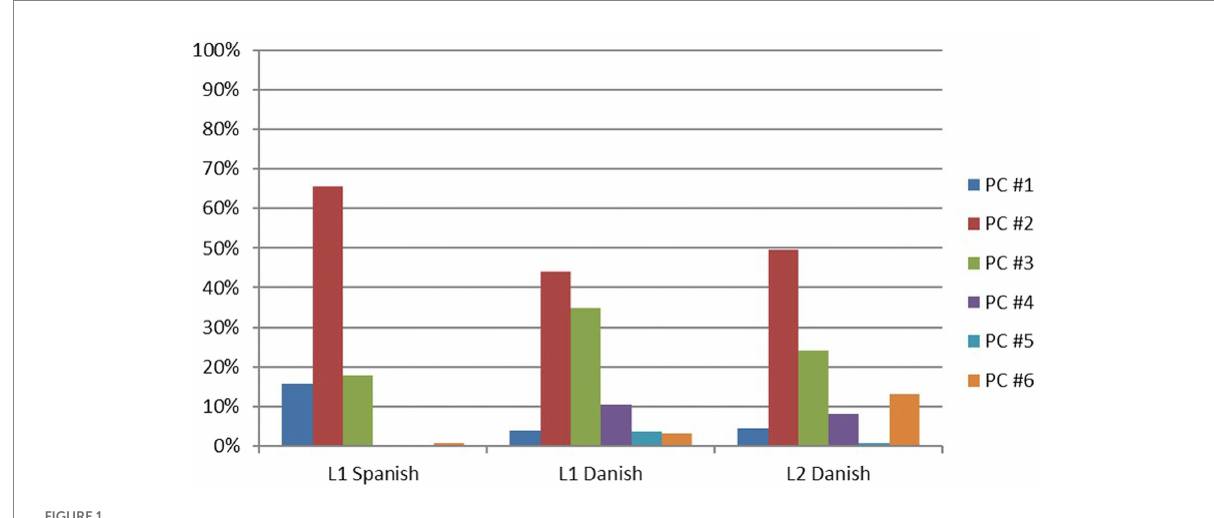
FIGURE 1 Percentage of placement construction use in the three speaker